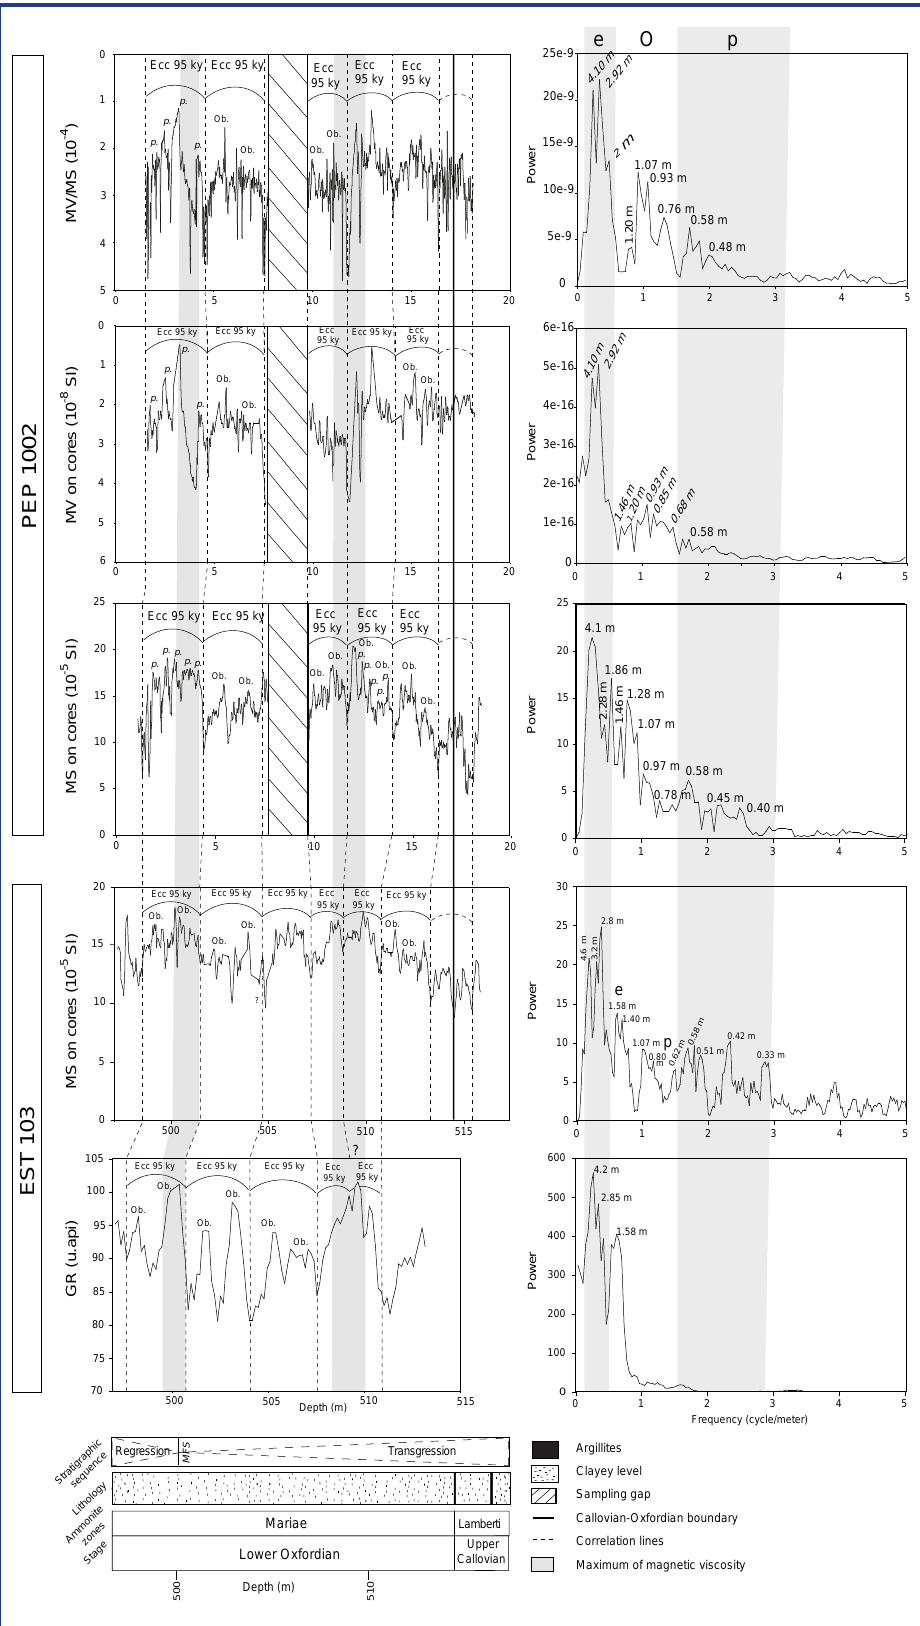
Figure 2. Biostratigraphy (Thierry et al., 2006), lithology (Huret, 2006), sequence stratigraphy interpretation and analysis of Gamma Ray (GR) well logging, and Magnetic Susceptibility (MS), Magnetic Viscosity (MV) and MV/MS ratio of the EST 103 and PEP 1002 boreholes. The light grey bands indicate zones with the strongest MV values. Presentation of 2 π –MTM power spectrum after trend rejection. Identification of orbital cycles in the recordings (3 point smoothing of the MS and MV curves), symbols: eccentricity 95 ky (e), obliquity (O) and precession